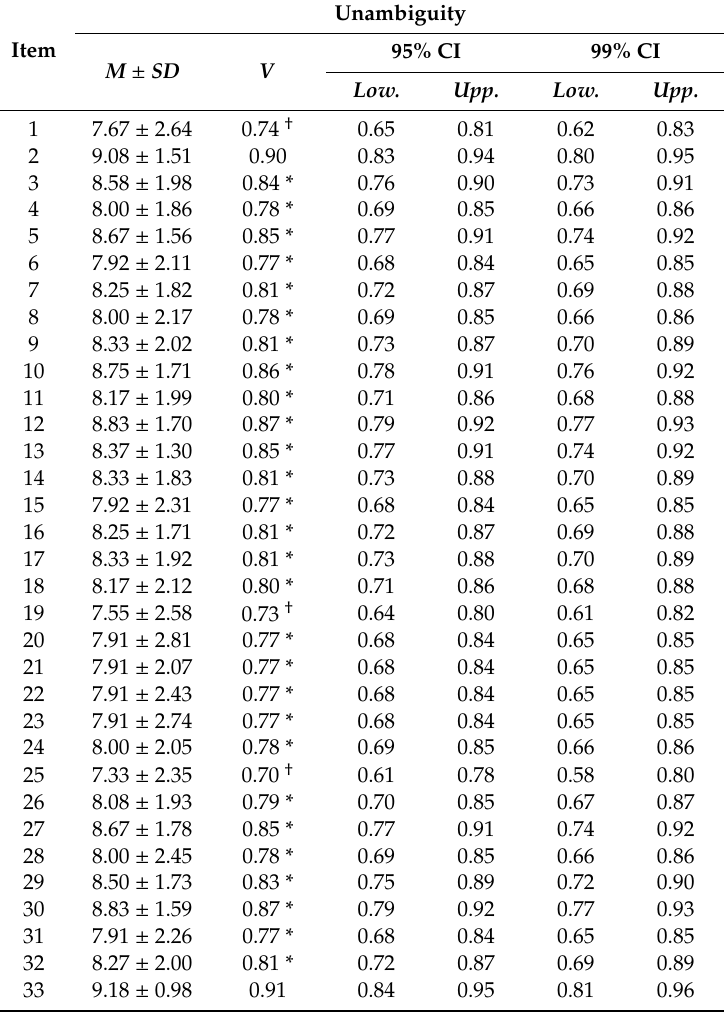
Table 6. Indexes of content validity (Aiken’s V ) and CI of 95% and 99% in the aspect of unambiguity.